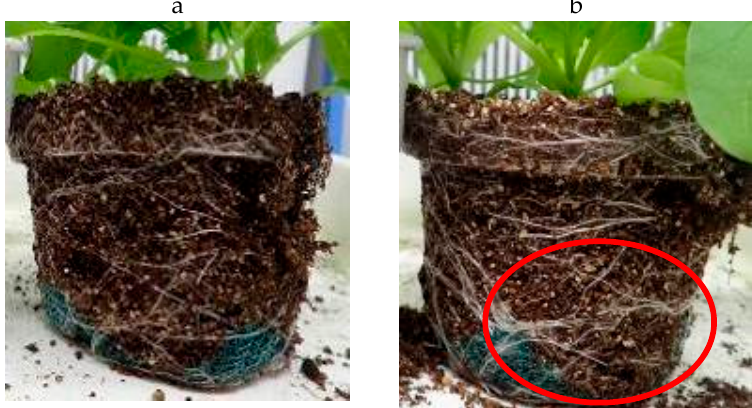
Figure 12. PDJ drip-wise ( a ) showed stronger e ff ect than PDJ spray ( b ). Both pictures were taken on the final day of pot culture (day 28). The left picture shows a smaller amount of roots and thinner roots in komatsuna treated by PDJ drip-wise at a concentration of 1000 ppm. The right picture shows relatively more remaining roots (indicated by red circle) and thicker roots in komatsuna treated by PDJ spray at a concentration of 1000